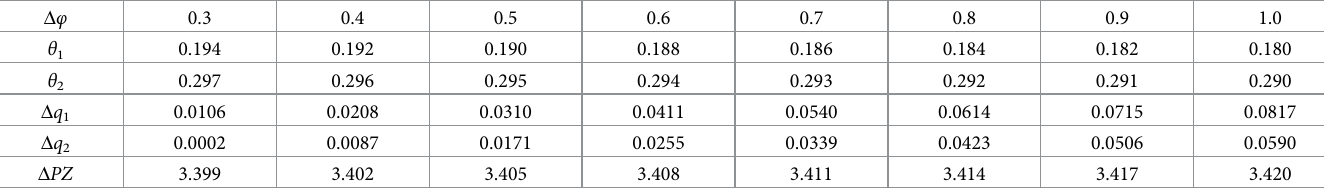
Table 1. With the change of EPD, the change of farmers’ increasing effort degree and enterprises’ increasing income. Δ φ 0.3